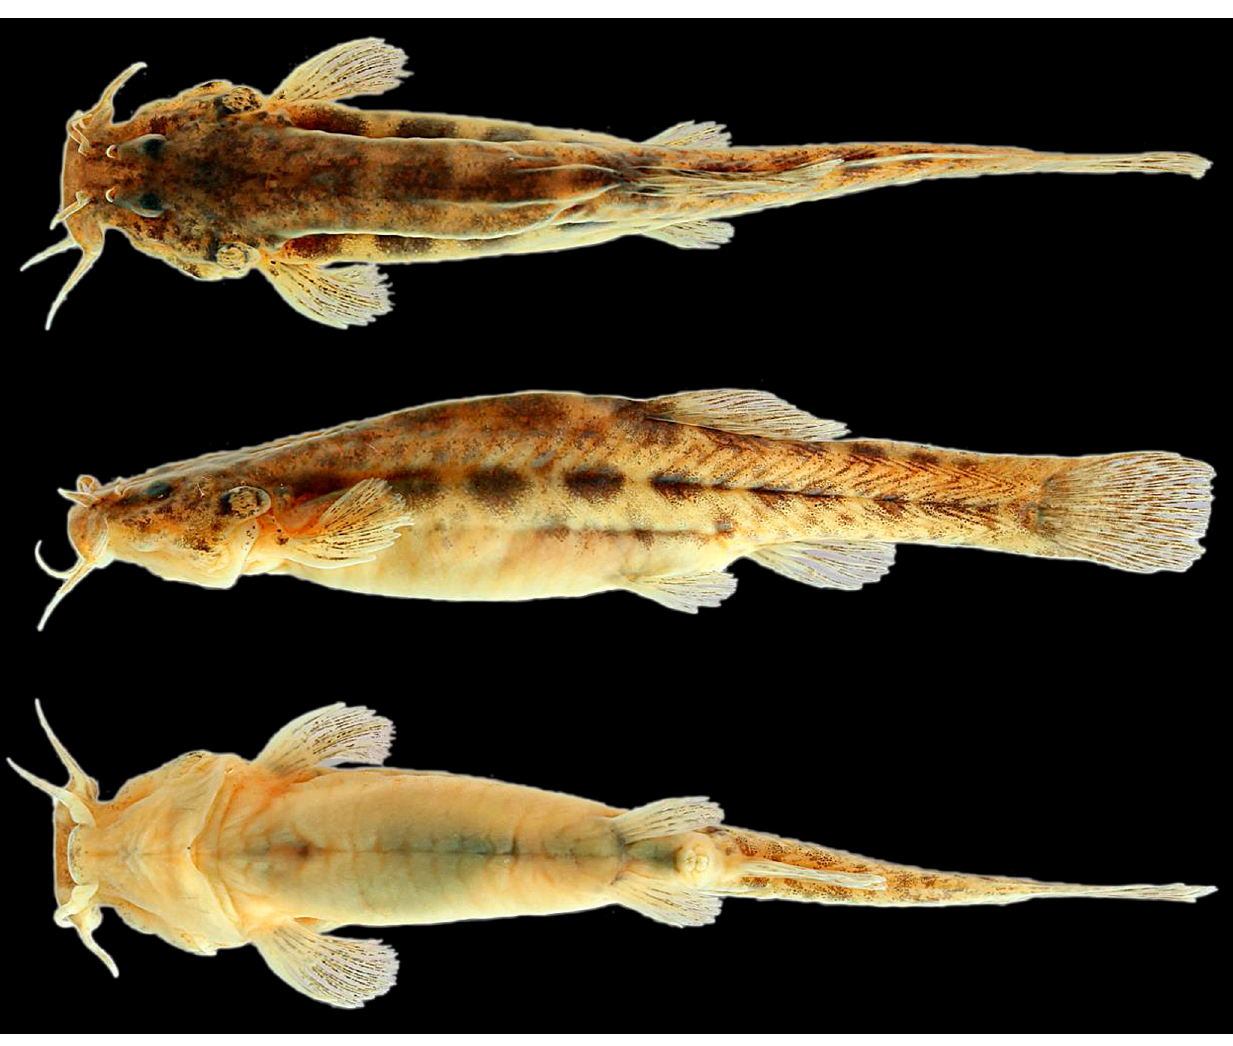
FIGURE 14 | Scleronema milonga , new species, holotype (MCP 54165; 37.8 mm SL), Brazil, Rio Grande do Sul, Dezesseis de Novembro, arroio Lageado Araçá, rio Ijuí drainage, lower rio